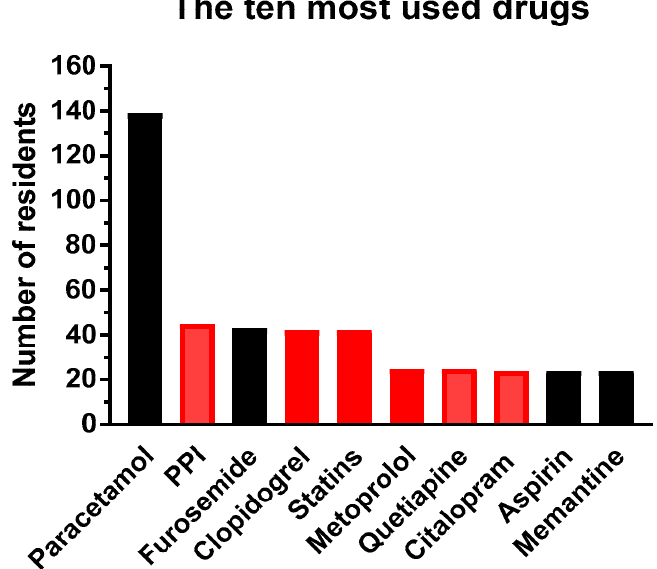
Figure 1. The ten most used drugs and the number of residents treated. Black columns are drugs with no guidelines and red columns are drugs with AG or N-AG. Proton pump inhibitors (PPI) constituted of pantoprazole (32 residents), lansoprazole (seven residents), omeprazole (three residents) all with AG for CYP2C19, and esomeprazole (three residents) with N-AG. Statins cover simvastatin (30 residents) and atorvastin (12 residents) both with AG for SLCO1B1. Metoprolol has AG, quetiapine has N-AG for CYP2D6, and citalopram has AG for CYP2C19.